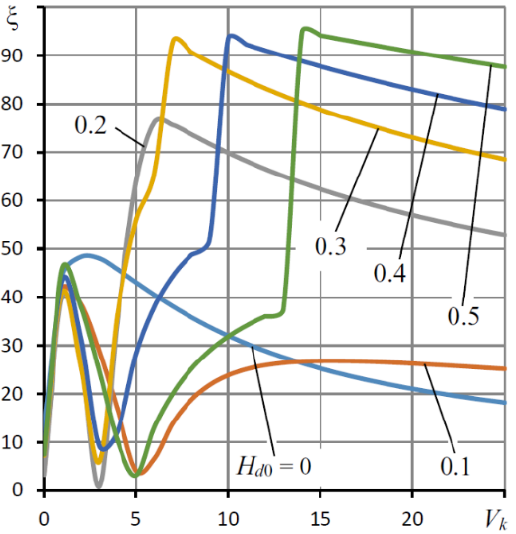
Figure 6. Graph of the dependence of the attenuation for the period ξ on the volume V k for different values of the parameter H d 0 at σ = 25.